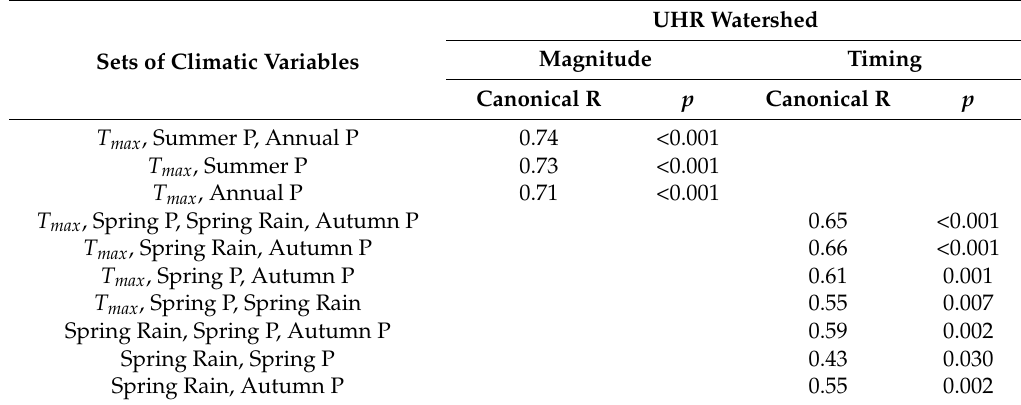
Table 4. Canonical correlation analysis between the set of climatic variables and high flow magnitude and timing in the UHR watershed.